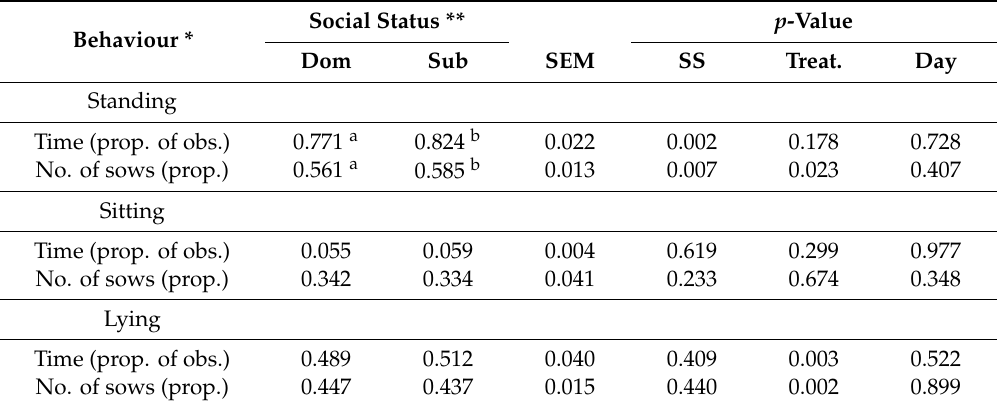
Table 5. E ff ects of social status enrichment treatment and day on focal sow postures observed in photo scans. LS Means of duration (proportion of observations) and number of sows (proportion of sows) in each